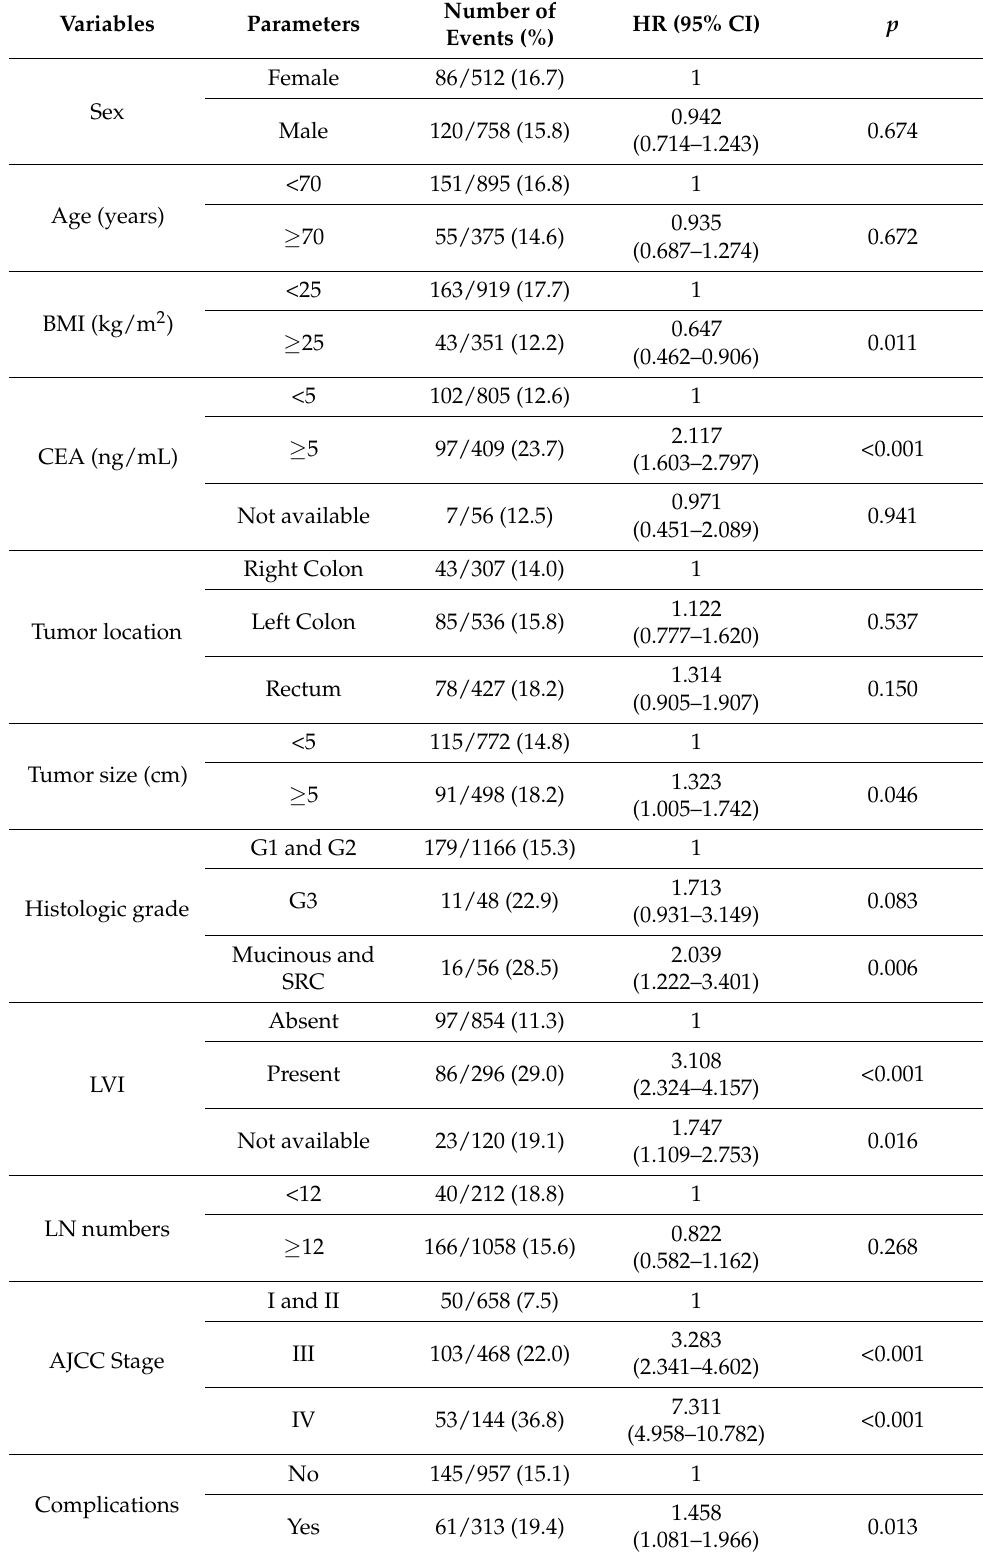
Table 2. Univariate analysis of factors associated with progression-free survival ( n =